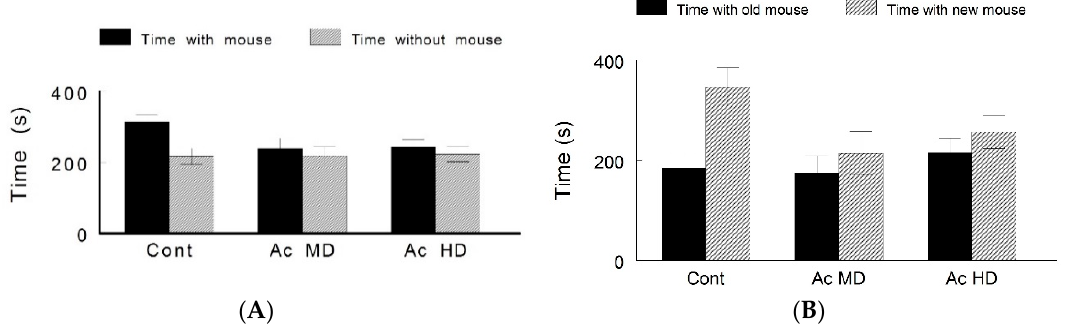
Figure 4. Three-chamber test to assess sociability and preference for social novelty. ( A ) Sociability (session 1: time spent in the chamber with the mouse versus the chamber without the mouse). ( B ) Preference for social novelty (session 2: time spent in the chamber with the old mouse versus the chamber with the novel mouse). Control animals showed normal sociability and preference for social novelty. Caffeine-treated mice showed decreased sociability and preference for social novelty.